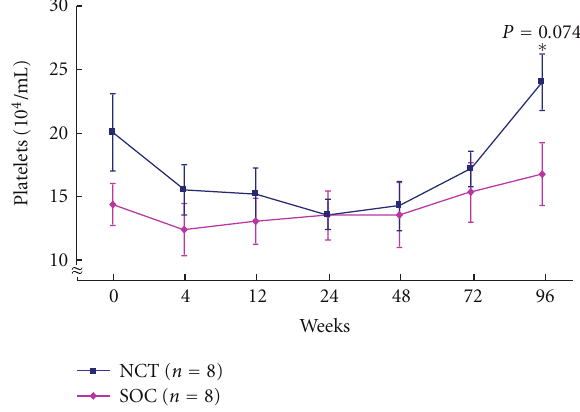
Figure 12: Changes in ALT level of peripheral blood during the NCT and the SOC in chronic hepatitis C patients with genotype 1 and high viral loads. NCT: novel combination treatment; cyclic and periodic IFN treatment (CPIT) consisting of induction treatment with natural interferon- β followed by maintenance treatment with natural interferon- α for 24 wks as induction approach followed by SOC for 48 wks. SOC: standard of care; ribavirin plus pegylated interferon α 2b for 48 wks.